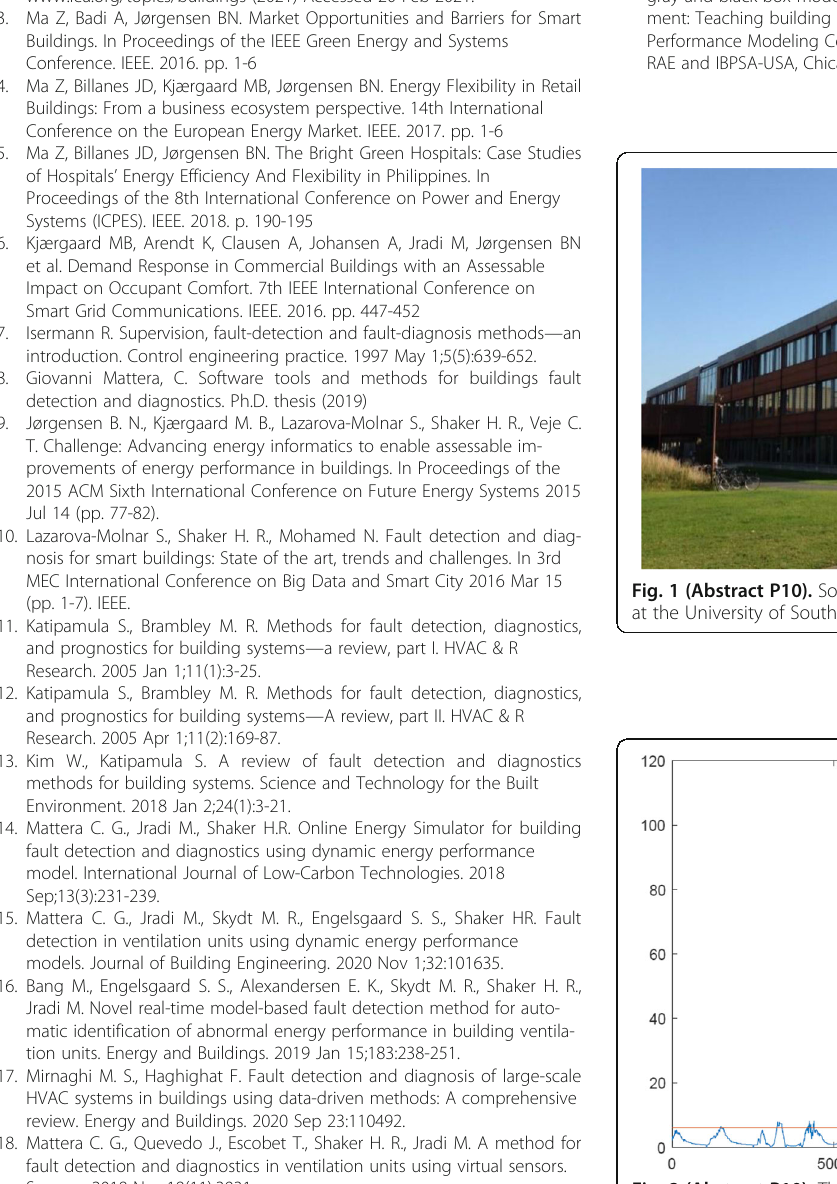
Fig. 2 (Abstract P10). The condition indicator and the threshold for testing data